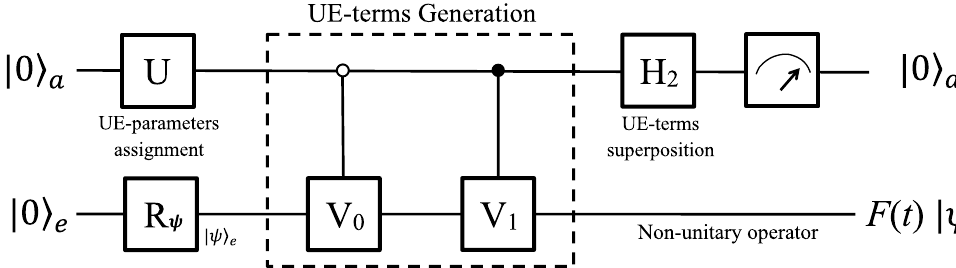
0 0 a e . The work qubit can be further rotated to an arbitrary state | � | �